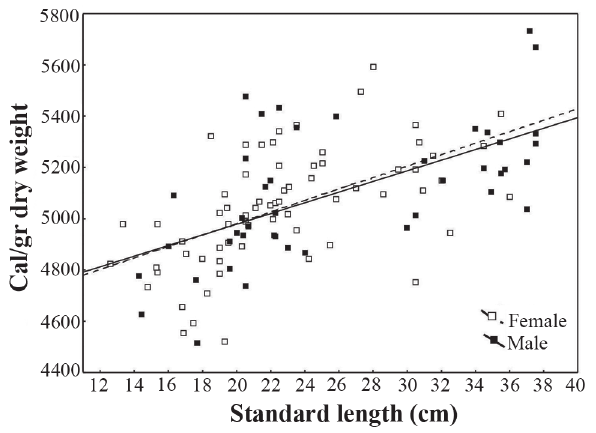
Fig. 5. Correlation between standard length and caloric content of females and males. Gonadal maturation stages: A = immature, B = resting, C = maturing, D = mature, E =